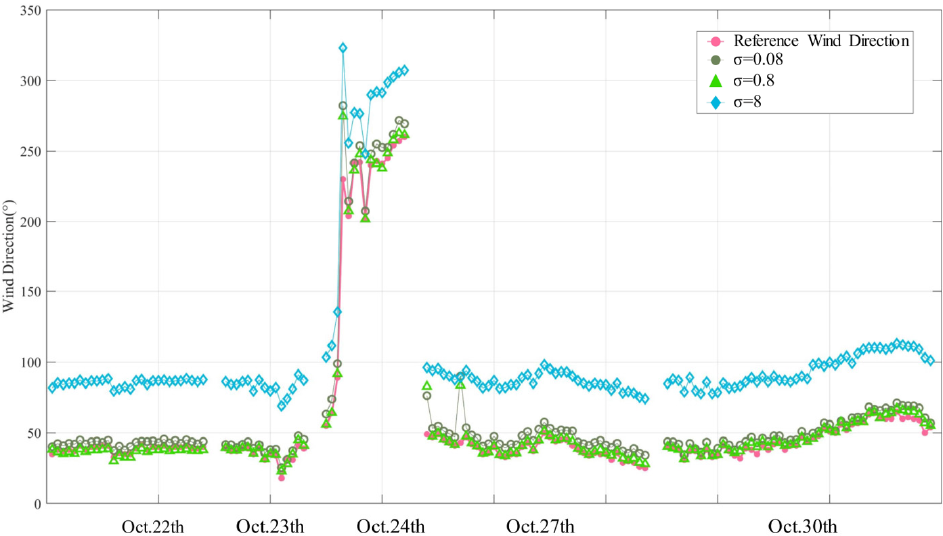
Figure 9. Wind direction sequence obtained by FC-GLCM algorithm when parameter is di ff er- ent. (The pink curve with the open points represents the wind direction measured by the vane ane- mometer.)